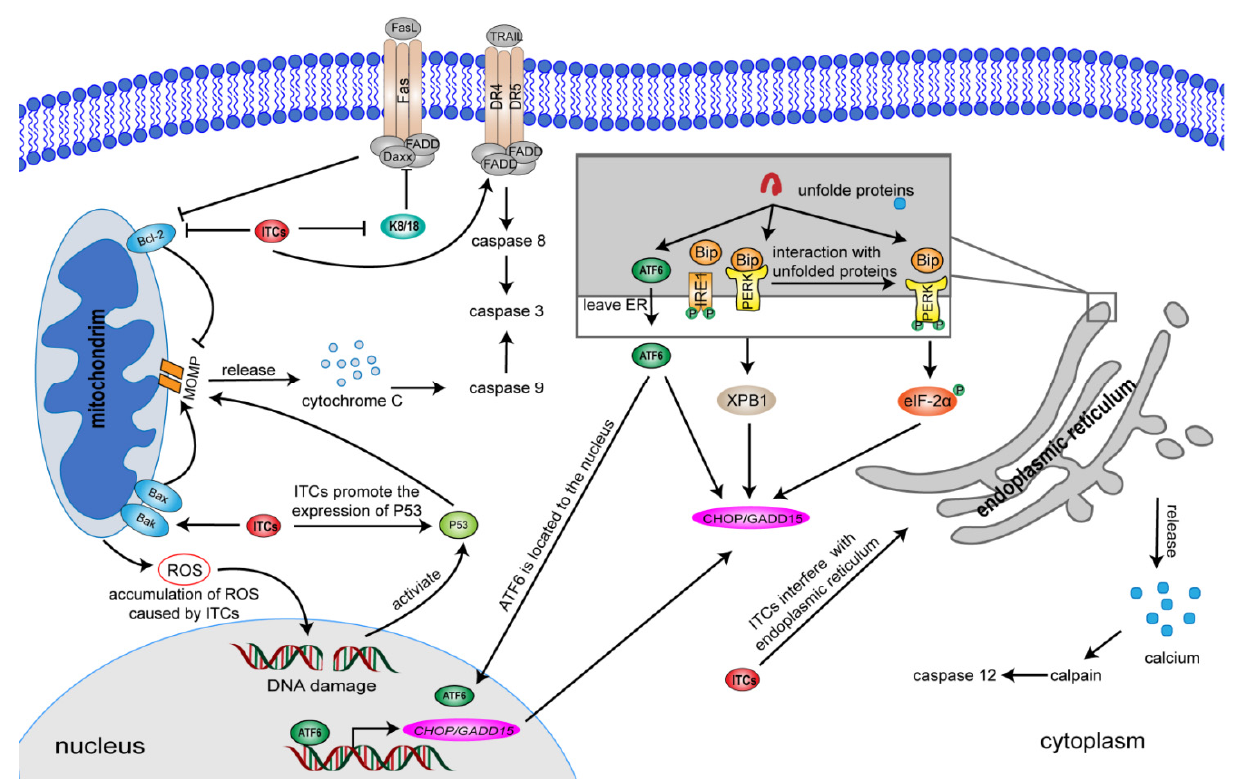
Figure 3. Regulatory pathways of apoptosis induced by isothiocyanates in hepatocellular carcinoma cells. Isothiocyanates (ITCs) mainly induce three apoptotic pathways in HCC. (i) ITCs trigger a series of mitochondria-related apoptotic responses, including decrease of mitochondrial membrane potential, increase of Bax expression and decrease of Bcl-2 expression, ultimately promoting the enhancement of mitochondrial outer membrane permeabilization (MOMP), which further causes the release of cytochrome C and promotes the production of ROS that causes DNA damage. (ii) ITCs induce endoplasmic reticulum stress (ESR)-related apoptosis pathway. As for this pathway, PERK and IRE1 are separated from molecular chaperones such as Bip/GRP78 due to the interaction between the unfolded/misfolded protein and molecular chaperones, and activated by autophosphorylation, promoting the production of elF-2 α and expression of XBP1. Elf-2 α and XBP1 further upregulate the levels of apoptosis signaling molecule CHOP/GADD153. Besides, ATF6 is also stimulated to transfer into the nucleus and promotes the transcription and expression of CHOP/GADD153. Moreover,